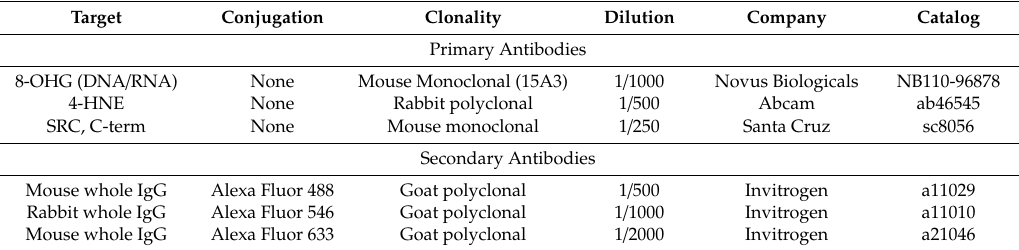
Table 1. List of antibodies used for immunofluorescence